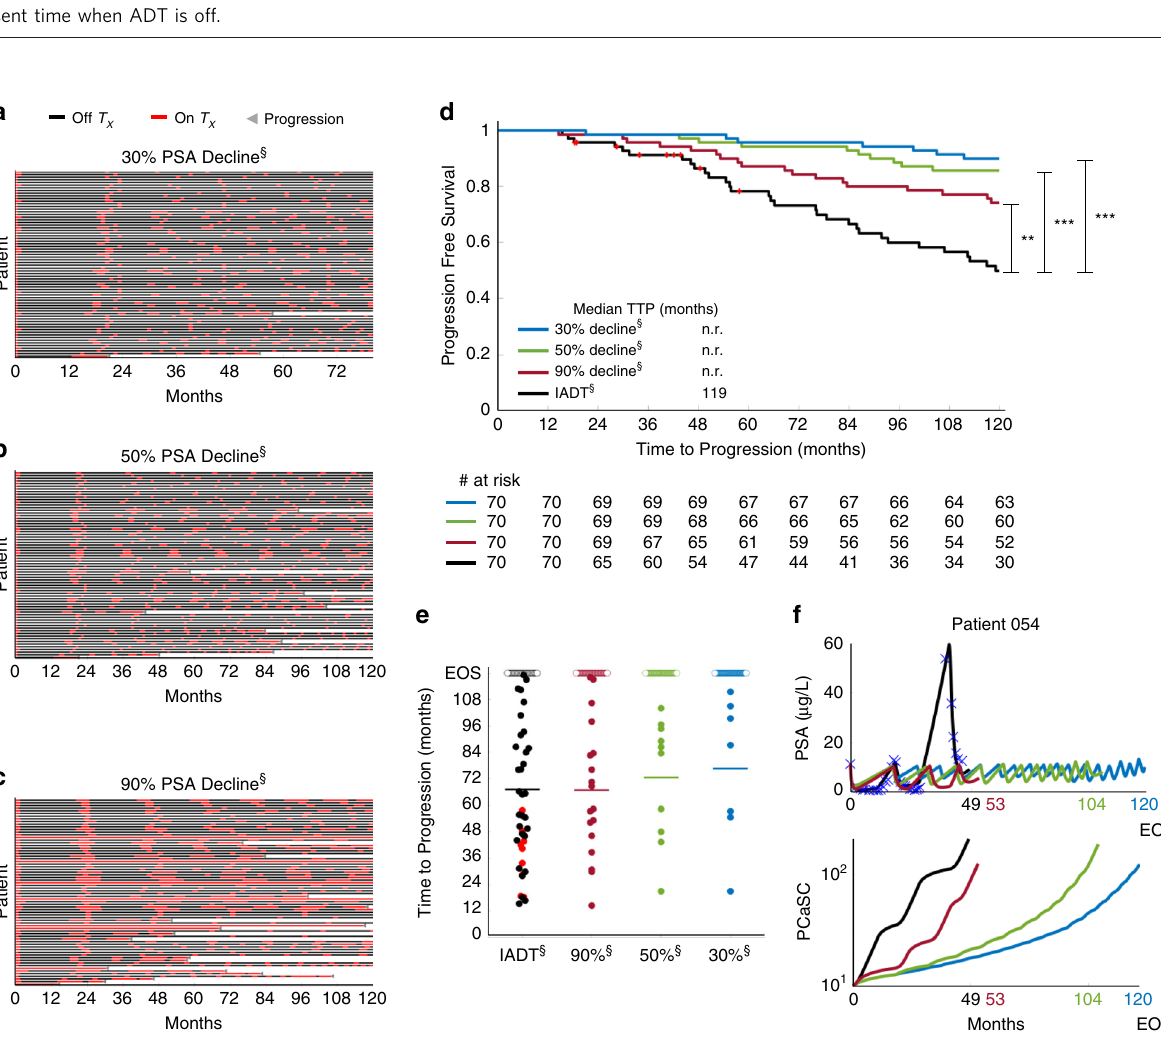
Fig. 6 Alternative threshold therapy can signi fi cantly improve TTP. a – c Treatment times for IADT with pre-treatment PSA decline triggers. Red and black denote when treatment is on and off, respectively. d Kaplan – Meier estimates of progression comparing standard IADT (black curve) with alternative therapy protocol using a 90% (maroon), 50% (green), and 30% (blue) PSA decline trigger (double S indicates predictive model simulation). All threshold levels show a signi fi cant increase in TTP when compared with standard IADT. Red symbols denote patients who experienced an adverse event/death prior to the conclusion of the trial. Statistical signi fi cance was determined using logrank test (IADT vs. 30% decline, 50% decline, and 90% decline: p = 0.004, p = 5.154E-06, p = 7.929E-08, respectively). Double and triple star denote p < 0.01 and p < 0.001, respectively. e TTP comparison between Bruchovsky IADT (black) and thresholds of 90%, 50%, and 30% PSA reduction. Open circles denote end of trial/simulation (EOS). Red dots denote patients who experienced an adverse event/death prior to the conclusion of the trial. Solid lines denote mean TTP (67.11, 66.79, 72.52, and 76.60 for standard IADT, 90%, 50%, and 30% PSA decline triggers, respectively). f Alternative threshold therapy simulations for Patient 054. With IADT, the patient became resistant after 49 months. Using a PSA decline of 90% and 50%, resistance could be delayed to 53 and 104 months, respectively. Using a PSA decline of 30%, the patient could continue on the protocol for >120